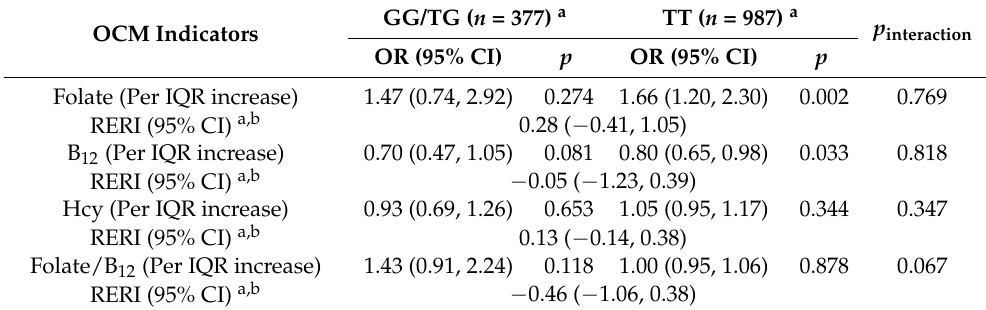
a Adjusted for age, ethnicity, education, drinking, smoking, parity, family history of diabetes, and prepregnancy BMI. In addition, in the folate group, the model was adjusted for serum B 12 and Hcy concentrations; in the B 12